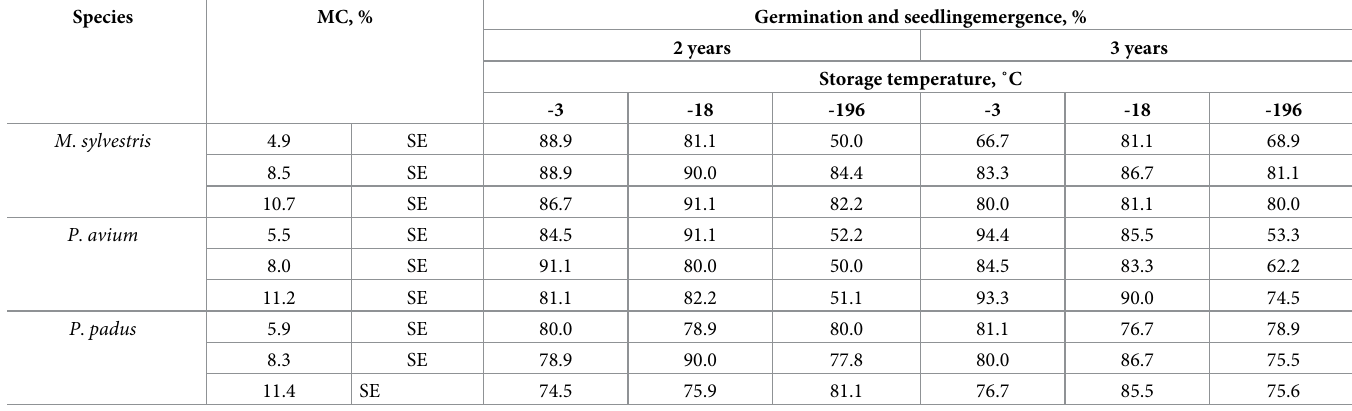
Table 1. Seedling emergence of Malus sylvestris , Prunusavium and Prunuspadus seeds (from Wawrzyniak et al. 2019) stored for two (2y) and three (3y) years and used as material in this report presenting the scheme of combination of storage temperature and moisture content (MC applied to seeds of each species);, SE–seed- lings